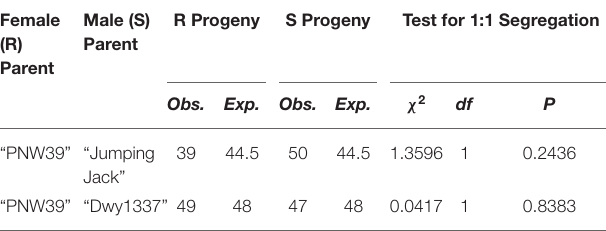
TABLE 1 | Chi-squared tests for goodness of fit among each mapping population. To satisfy the null hypothesis, a 1:1 segregation is expected of resistant (R) to susceptible (S)